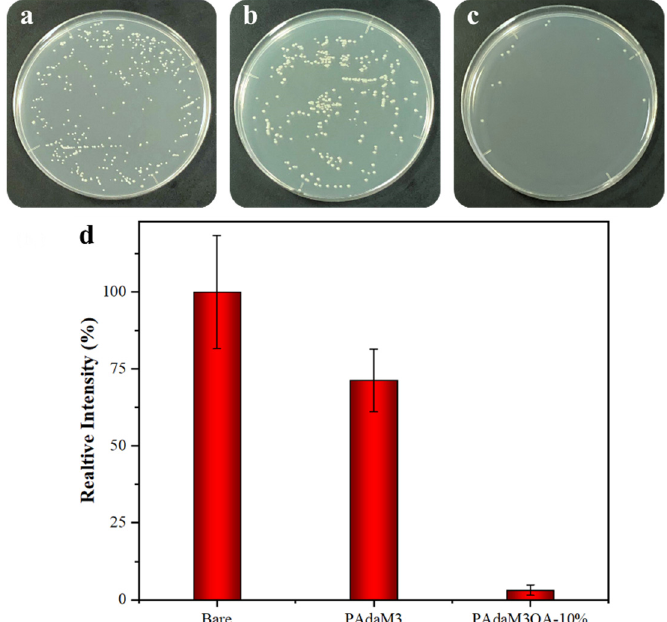
Figure 11. ( a ) Images of bacterial colonies of ( a ) bare, ( b ) PAdaM3, and ( c ) PAdaM3QA − 10% coatings; ( d ) comparison of antifouling performances of bare, PAdaM3, and PAdaM3QA − 10% coatings. According to the results of the WCA, the PAdaM3QA − 10% coating had good